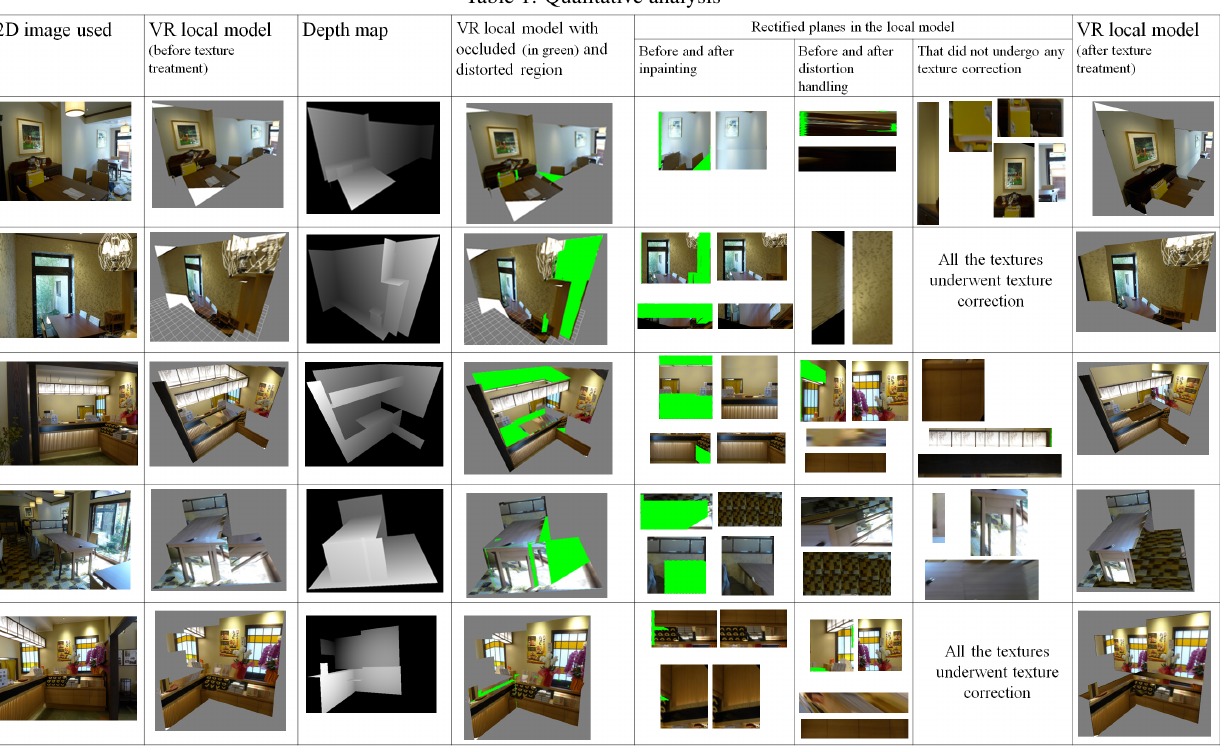
Table 1: Qualitative